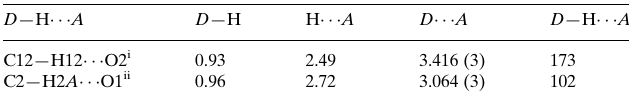
Hydrogen-bond geometry (A˚ , (cid:2)